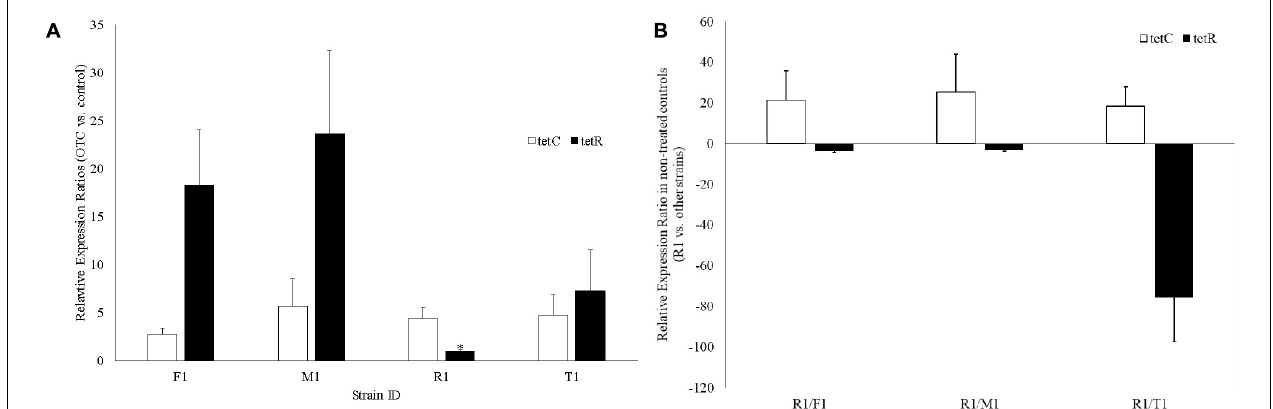
FIGURE 4 | Gene expression analysis of the tetC and tetR genes in the four oxytetracycline-resistant Xanthomonas arboricola pv. pruni strains. (A) Fold expression changes of tetC and tetR after treatment with oxytetracycline (25 mg/L). *There was no change of tetR expression in R1 (relative expression ratio: 1.05, which was significantly lower than the tetR expression in the other three strains, p < 0.001); (B) Relative expression ratio of tetC and tetR in R1 vs. the other strains without oxytetracycline treatment.